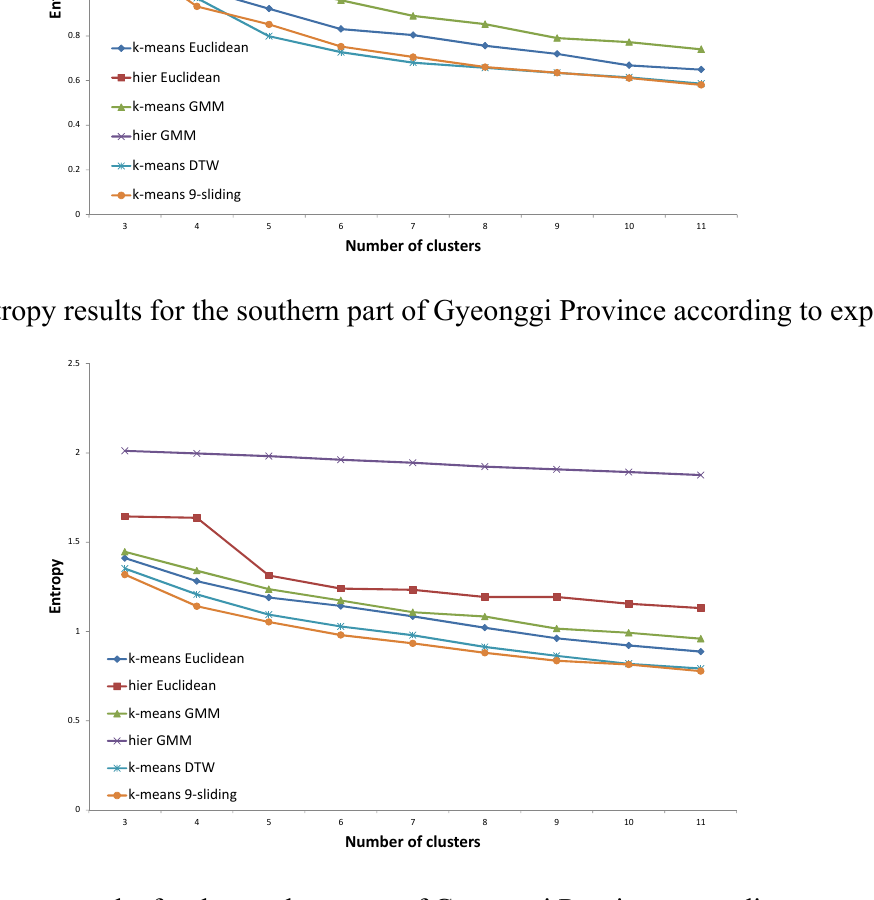
Figure 9. Entropy results for the northern part of Gyeonggi Province according to expert #1.